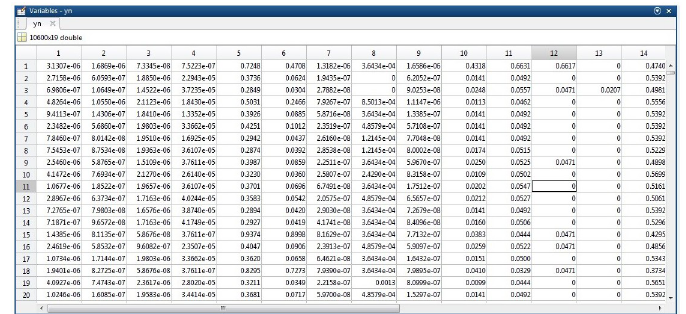
Fig 3. Snapshot of dataset